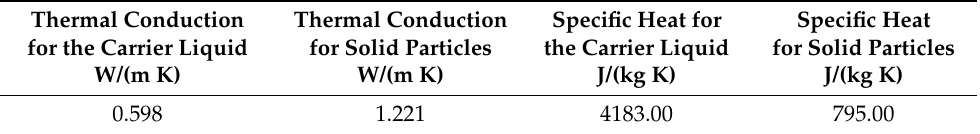
Table 2. Thermal properties for limestone and liquid phase; D = 0.02 m; Tw = 293.15 K; q = − 500